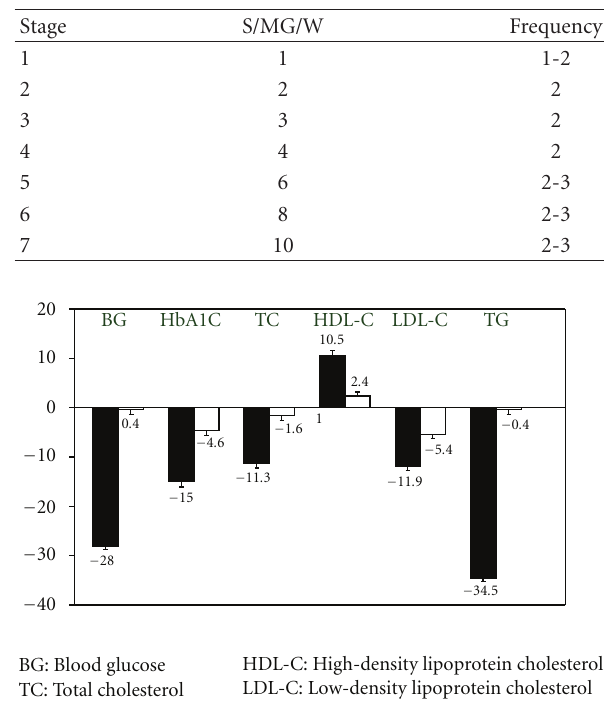
Figure 1: Percent change in metabolic parameters after 4 months RT (black) or AET (white) in patients with T2D. Whiskers represent standard deviation